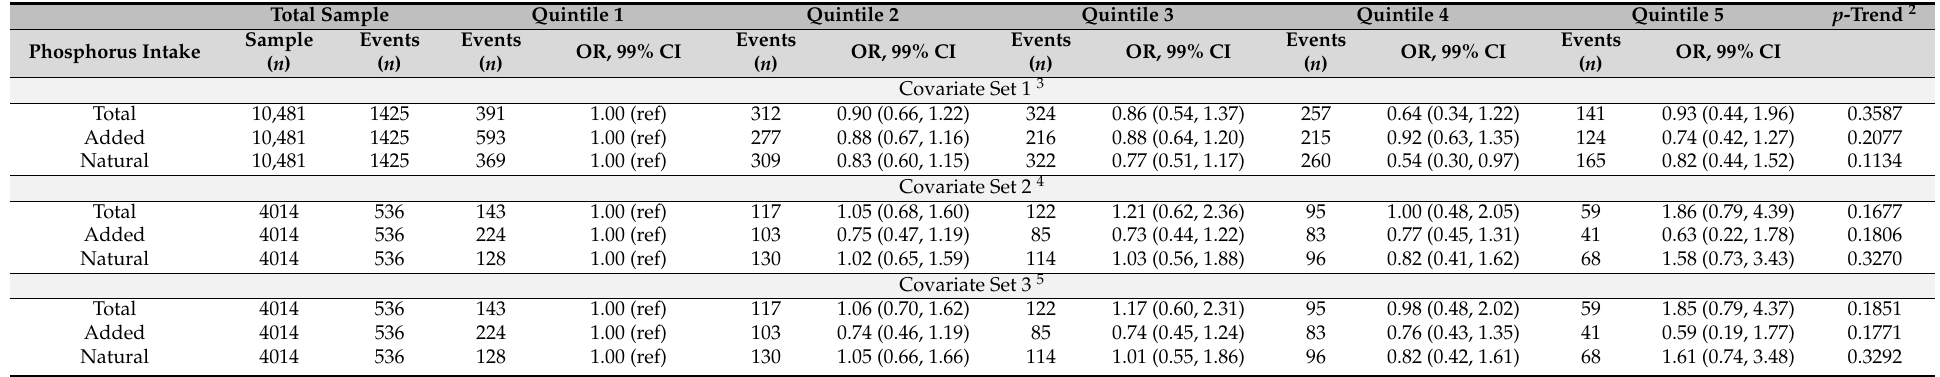
Table 4. Dietary phosphorus intake 1 association with mortality by quintile of intake (g) in adults 19+ years of age and older, NHANES